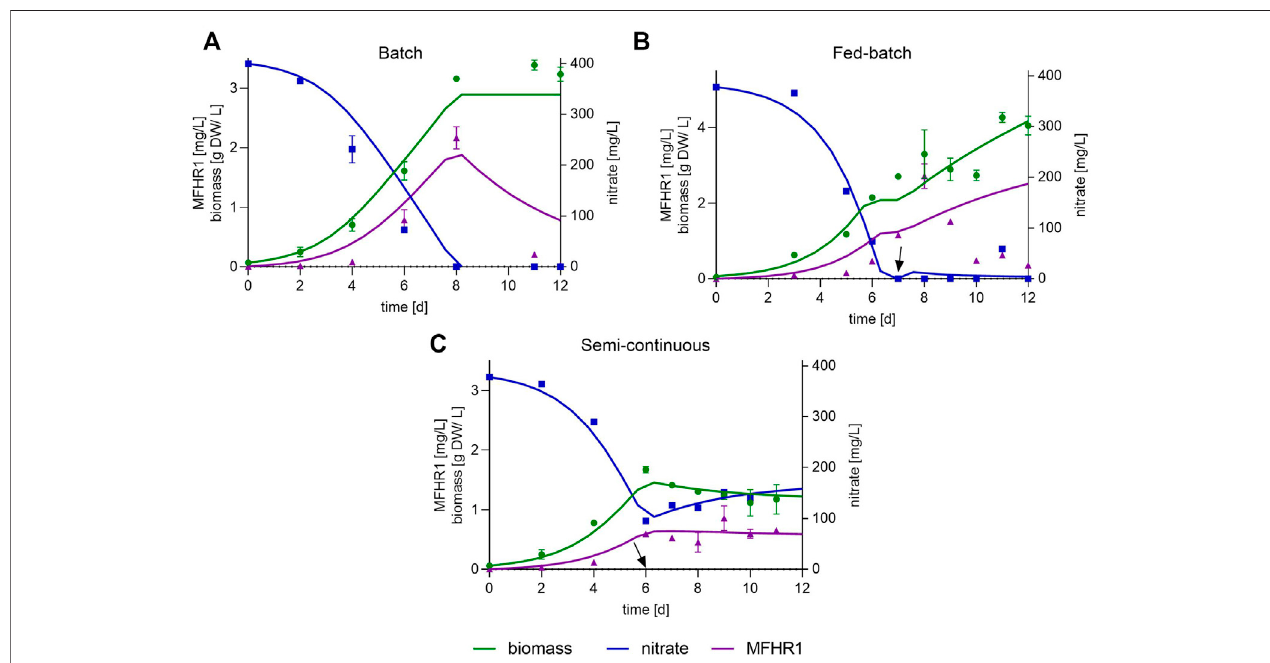
FIGURE 2 | Mathematical modelling and simulation to describe the growth kinetics of the transgenic moss line B and the production of the recombinant protein MFHR1. Parameters were estimated using differential evolution (DE) implemented in Scipy in Python 3.6. The solid lines represent modelled data; experimental data are shown with symbols (A) Batch mode, (B) Fed-batch mode, (C) Semi-continuous mode. This operation was conducted between day 6 and 11. Data represent mean ± standard deviations (SD) from two measurements. The starting day of fed-batch and semi-continuous operations are marked by